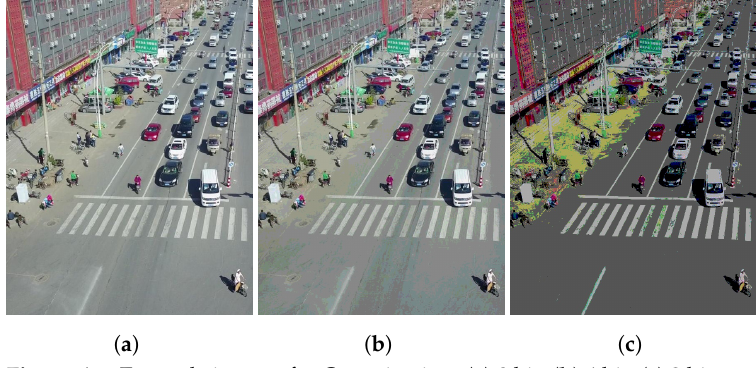
Figure A1. Example images for Quantization. ( a ) 8 bit; ( b ) 4 bit; ( c ) 2 bit.